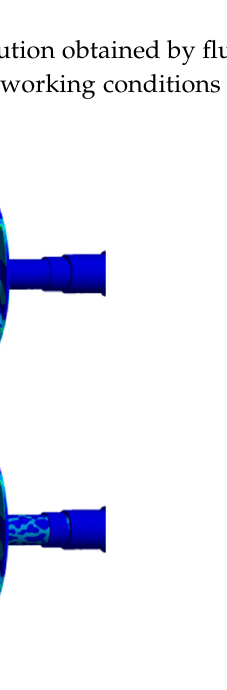
Figure 14. Equivalent stress distribution cloud diagram of fluid-structure coupling of impeller under different working conditions, Pa. ( a ) 0.4 Q d . ( b ) 1.0 Q d . ( c ) 1.3 Q d .